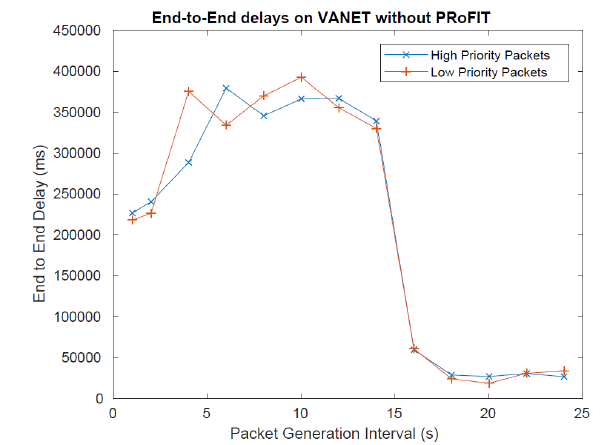
Figure 13. End-to-End Delays on VANET without PRoFIT